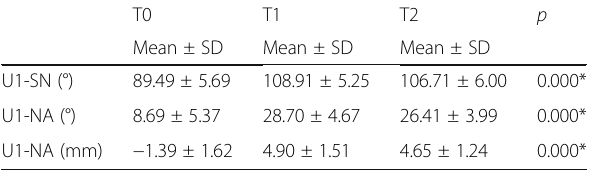
Table 1 Cephalometric measurements of the study group